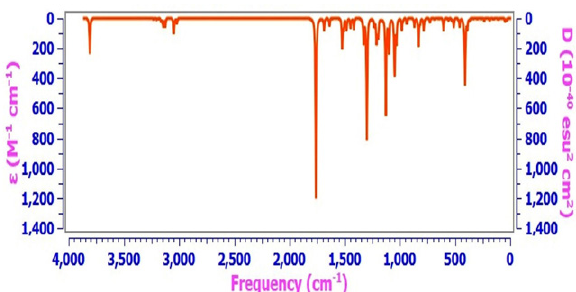
Fig. 2b . Theoretical FTIR spectrum of Methyl 2-((4-chlorophenyl) (hydroxy)methyle) acrylate [MBHA